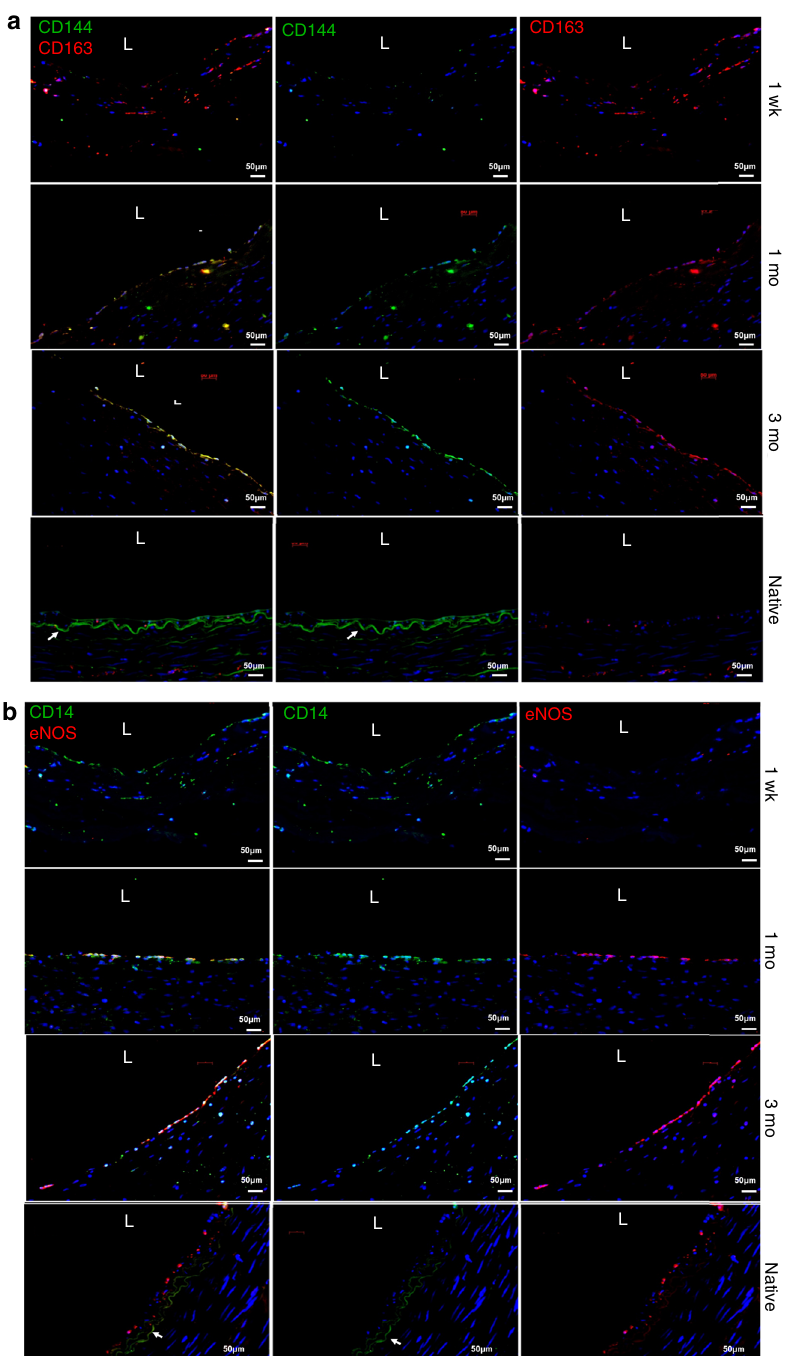
Fig. 1 Monocytes are incorporated as the endothelium of acellular vascular grafts. Immunostaining of explanted VEGF-based A-TEVs at the indicated time points of 1 week, 1 month, and 3 months compared to native carotid artery. a Co-staining for the macrophage marker CD163 (red) and the endothelial marker CD144 (green). b Co-staining for the monocyte marker CD14 (red) and the functional endothelial marker eNOS (green). Note that at 1-week lumens are devoid of EC markers but express MC markers, CD14 and CD163. At 1 and 3 months lumens comprise of cells co-staining for MC (CD14, CD163) and EC markers (CD144, phosphorylated (active) eNOS). White letter “ L ” indicates the lumen. Scale bars 50 µ m. White arrows indicate auto- fl uorescent inner elastic and non-classical MC (CD14 + /CD16 + , FN: 28.5 ± 2.1%; VEGF: for each antibody and corresponding IgG controls are shown in 26 ± 3.4%). As expected, VEGF-captured MC were highly enri- Fig. 3d – g. IgG gating is depicted in Supplementary Fig. 1. ched in VEGFR1 expressing cells (99 ± 1.2% were VEGFR1 + ), as were the FN bound cells, albeit to a lesser extent (73 ± 5.6%). Inducing spreading and proliferation of surface captured MC . However, no VEGFR2 + cells were found on either the VEGF or Next, we examined whether MC that were attached on VEGF or FN coated surface beyond background noise (~2%). Histograms FN could be differentiated into functional EC similar to what was